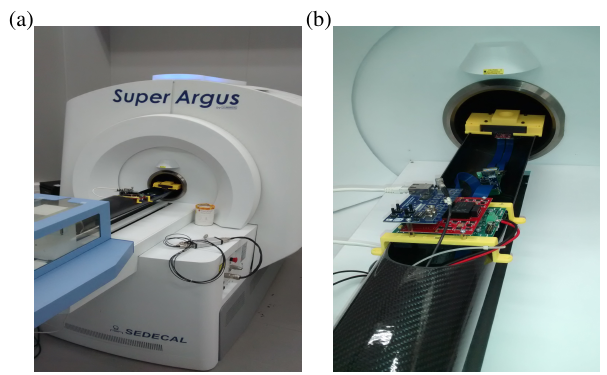
Fig. 1: (a) Super Argus 4R and probe. (b) Detail of the probe.